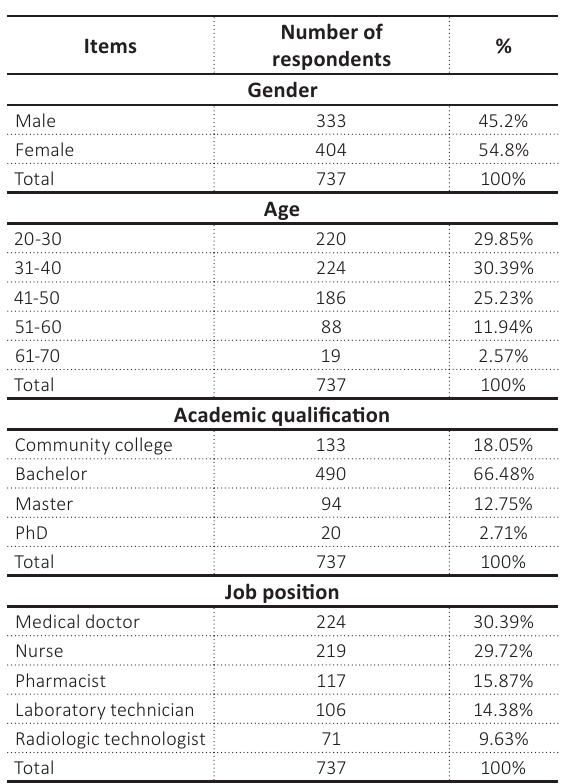
Table 1. Demographic characteristics